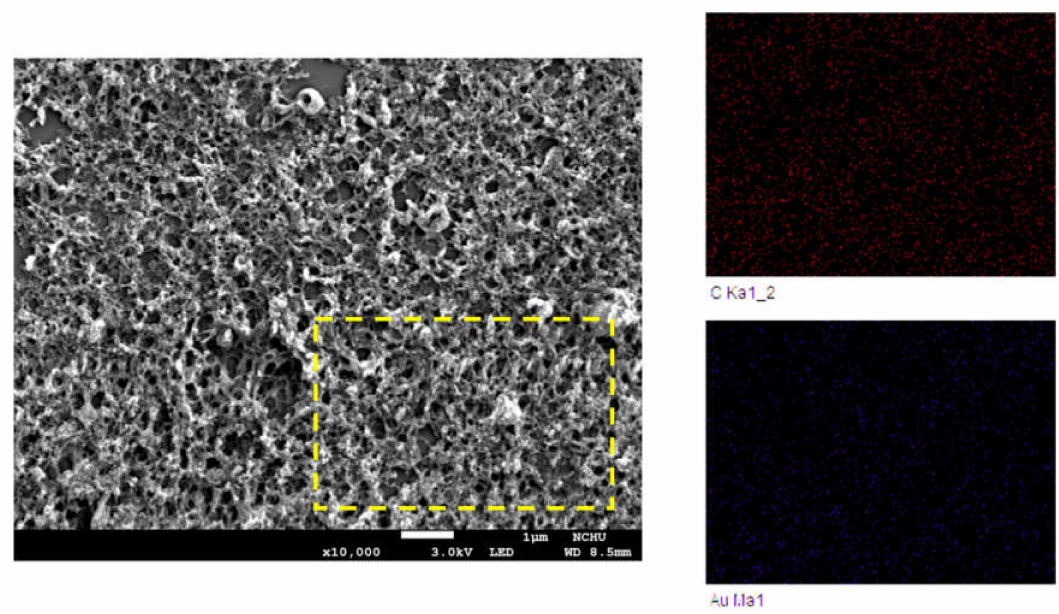
Figure 3. SEM image and corresponding elemental analysis, EDS, of pectin-capped AuNPs on a silicon